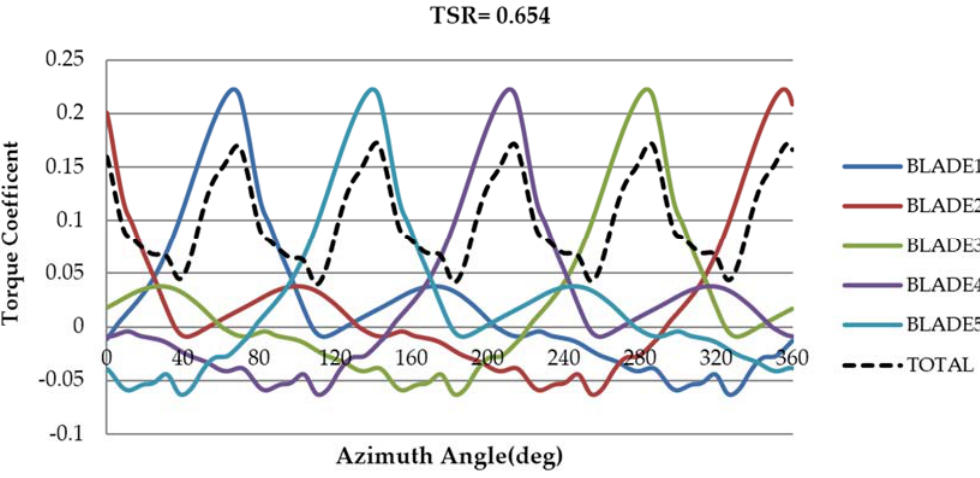
Figure 16. Predicted torque coefficient for five individual blades.